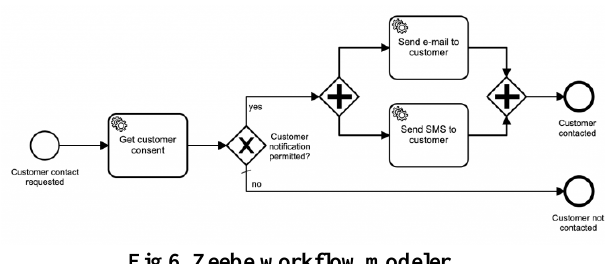
Fig 6. Zeebe workflow